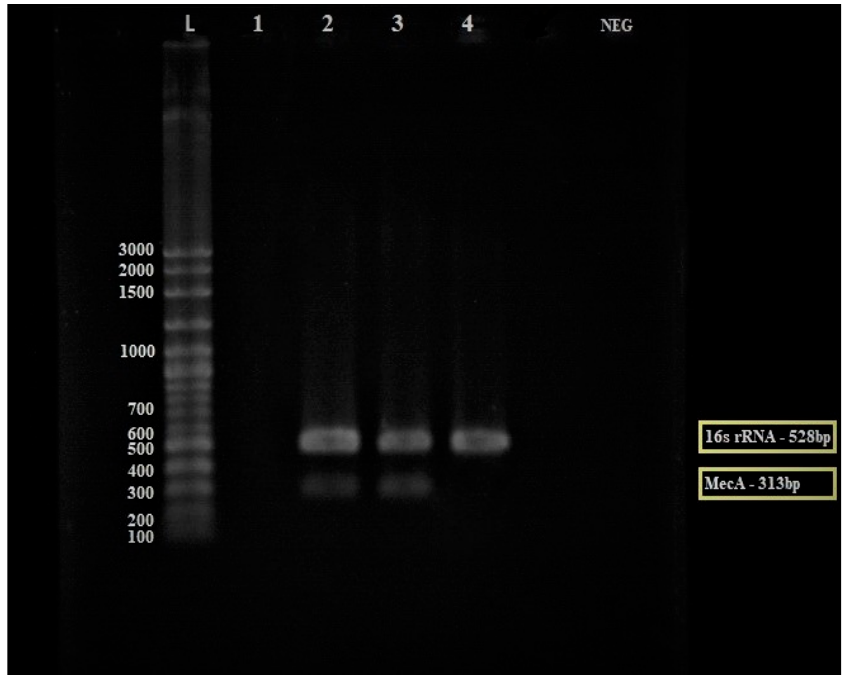
Figure 3. Electrophoresis gel (3% agarose) of the PCR products of the mecA gene for the discovery of the mecA gene from MRSA (Lane 2–3) and MSSA (Lane 4) isolates. Lane L = 100 bp ladder, Lane 1 = empty lane, Lane 2 and 3 = MRSA isolates, Lane 4 = MSSA control isolate, and Lane NEG = negative control. The yellow box: The mecA gene was expressed in MRSA strain while the 16S rRNA gene was expressed in both MRSA and MSSA strains.